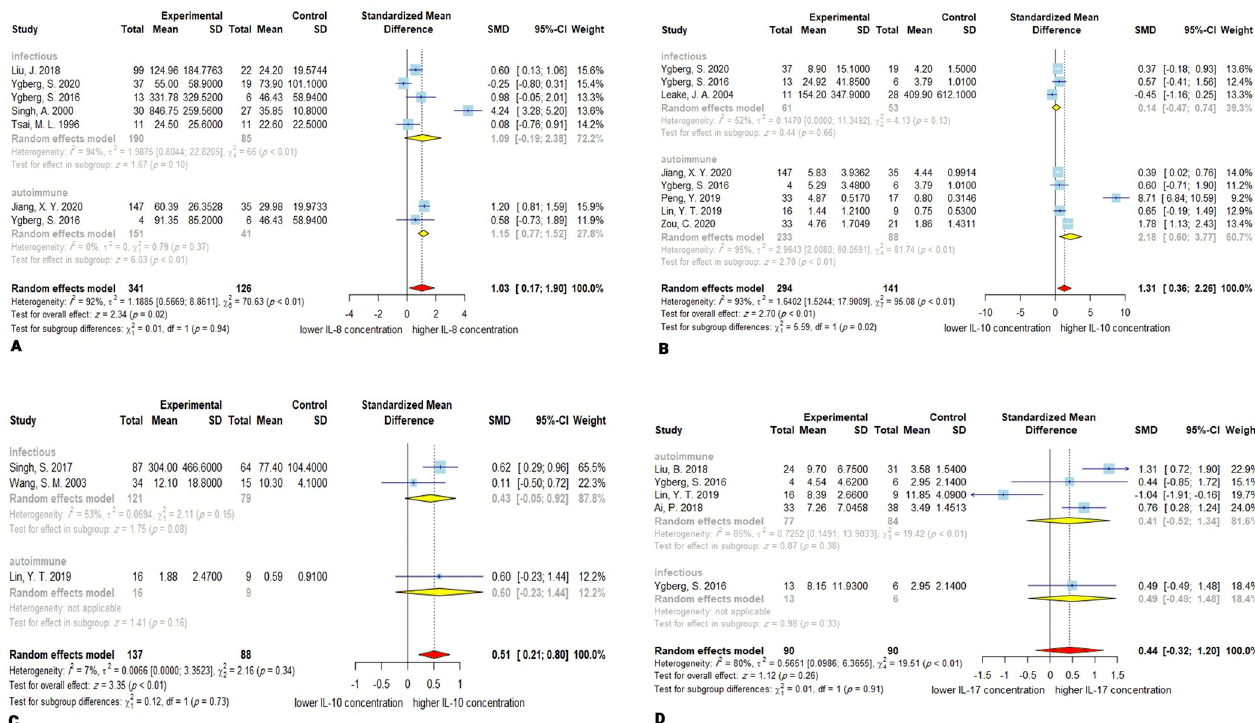
Fig 3. Forest plots for results of meta-analysis for IL-8 CSF concentrations (A) , IL-10 CSF concentration (B) , IL-10 serum/plasma concentrations (C) , and IL- 17 CSF concentrations (D) . SD, standard deviation; SMD, standardized mean difference; CI, confidence interval.